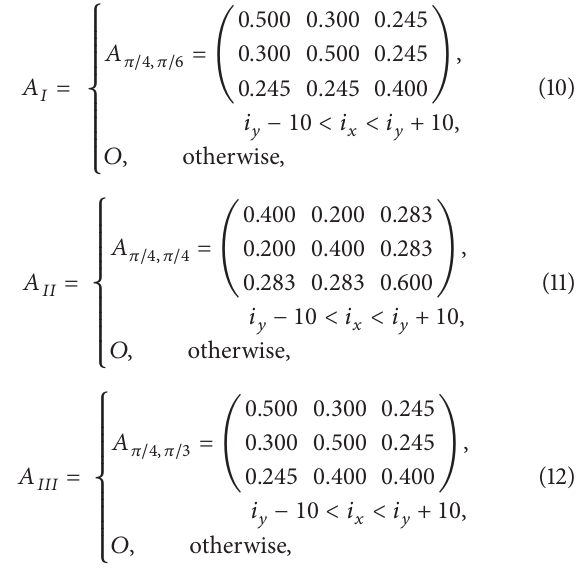
respectively. The second and third row of 𝑇 𝜃,𝜙 is chosen to make 𝑇 𝜃,𝜙 orthogonal